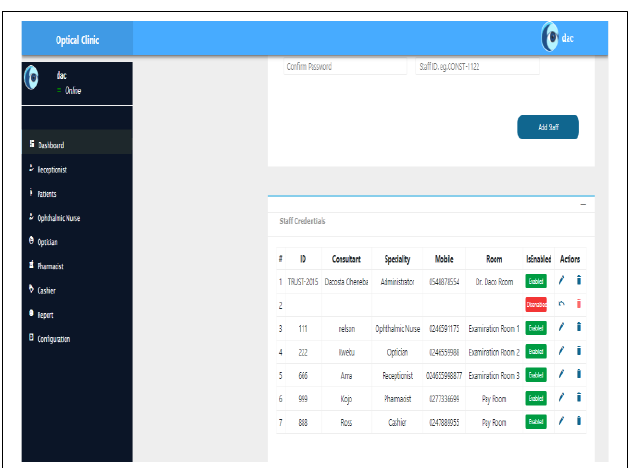
Figure 22. Appointment Interface